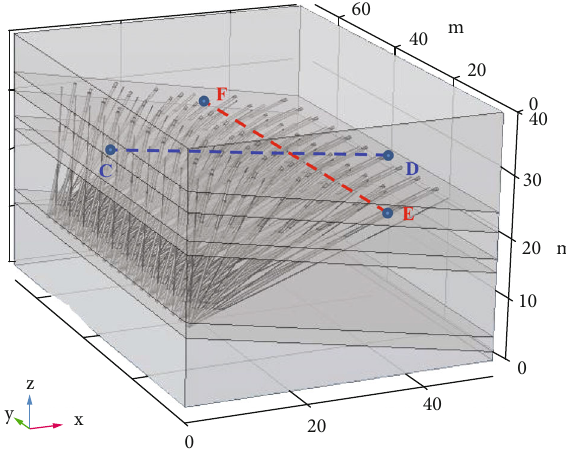
Figure 5: Geometric model of gas extraction for roadway